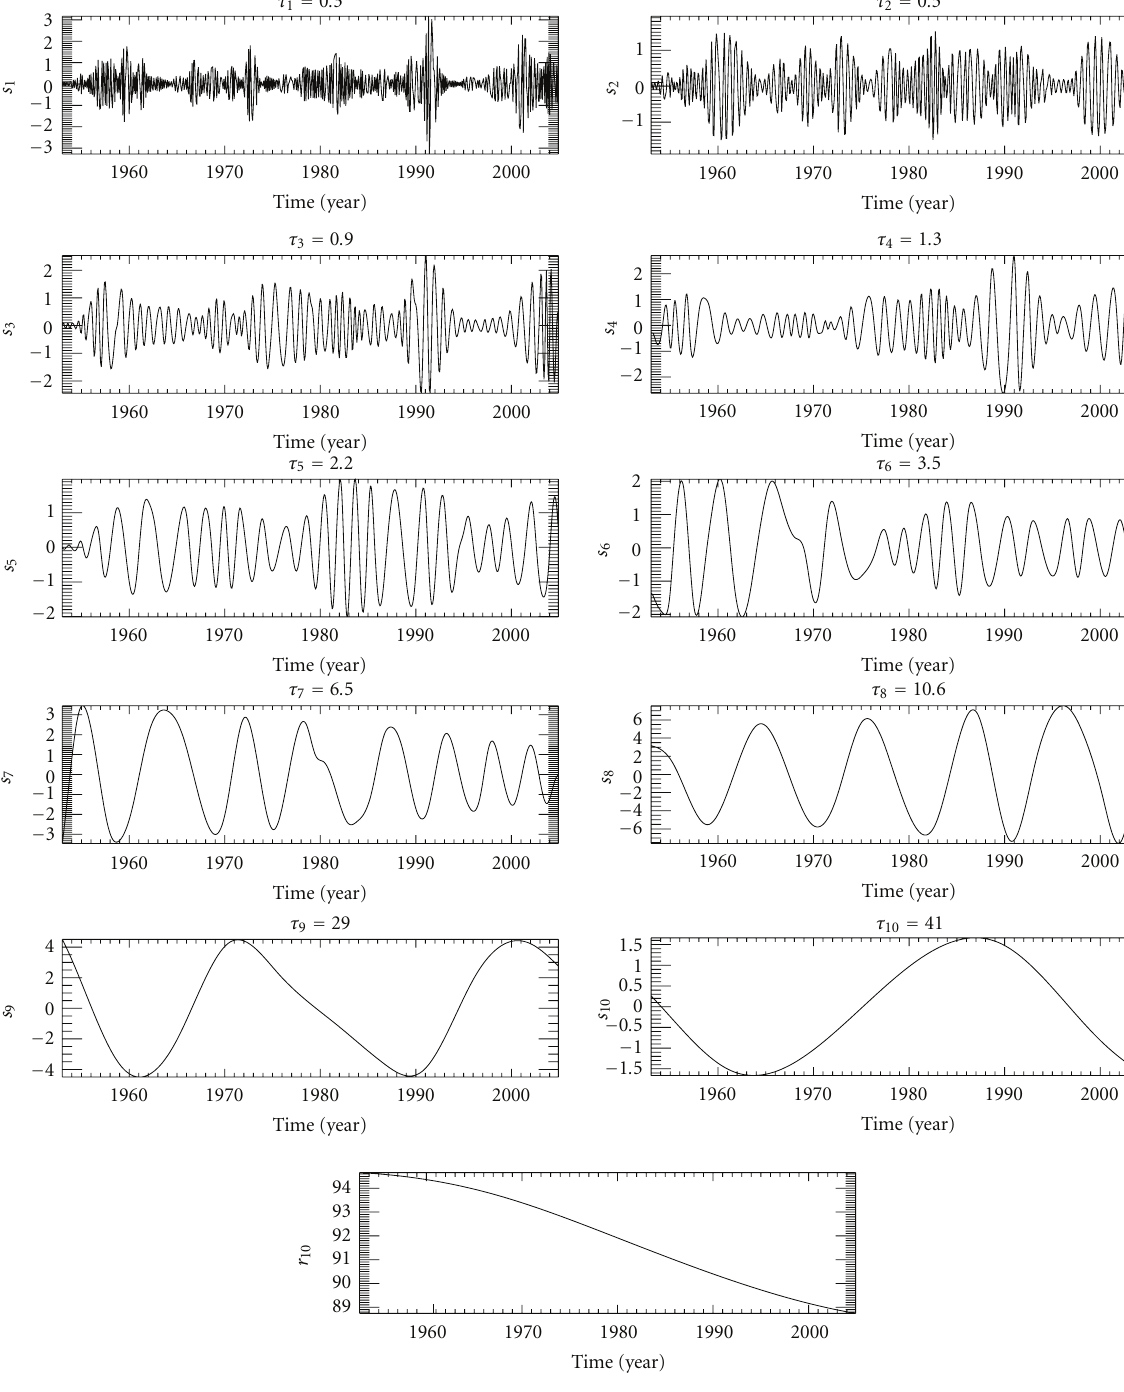
each maximum of the 11 yr cycle). The QBO contribution is estimated to be higher than 30% with respect to the amplitude of the ∼ 11 yr mode for all the considered cycles (34%, 32%, 38%, 54%, and 31% for cycles 19, 20, 21, 22, and 23, resp., in agreement with the findings of Laurenza et al.